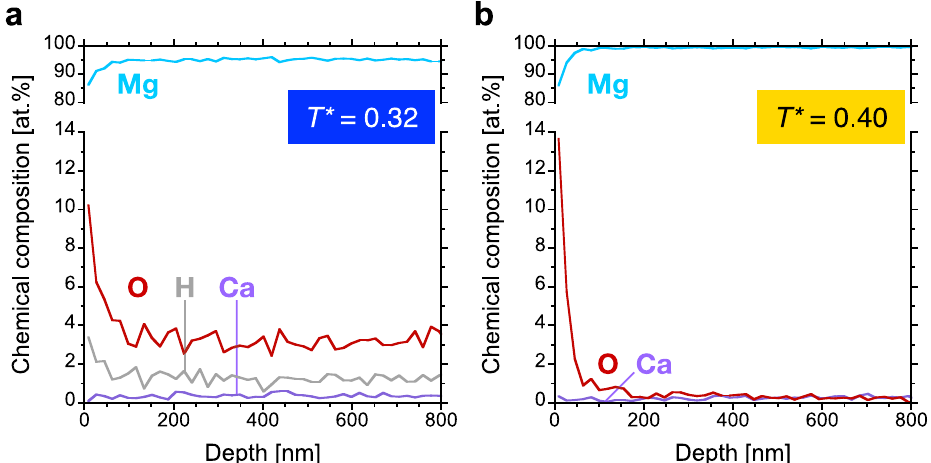
Figure 3. Thin film chemical compositions. Elastic recoil detection analysis depth profiles are presented for the (Mg,Ca) solid solution thin films grown at ( a ) T* = 0.32 and ( b ) T* = 0.40. In addition, average calcium concentrations were determined by Rutherford backscattering spectrometry and the corresponding data can be found in Fig. SI2. The figures were created with KaleidaGraph 4.5.3 (https:// www. syner gy. com).